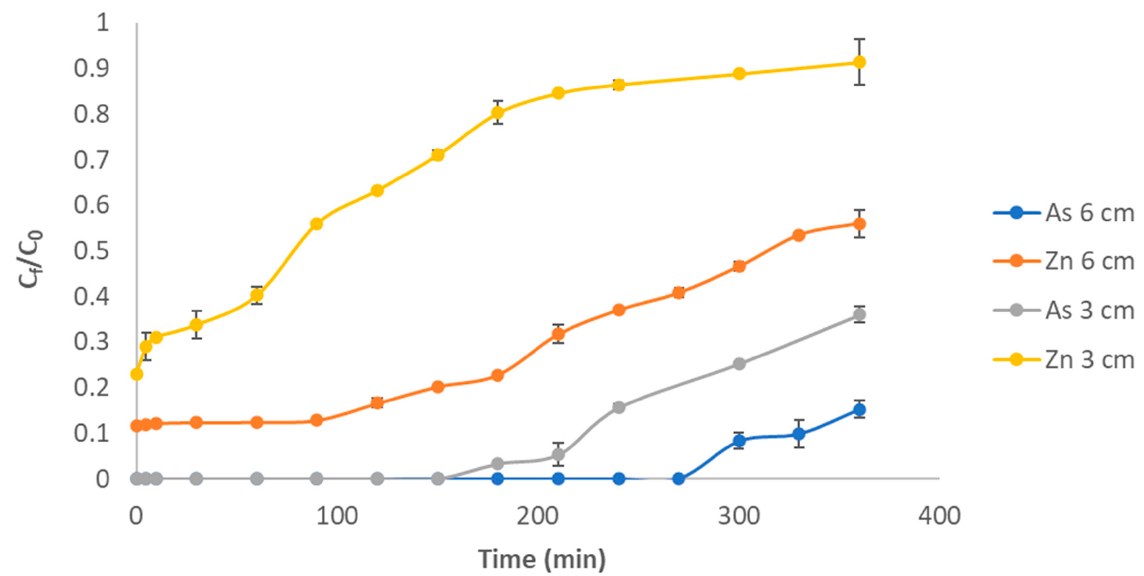
Figure 8. Arsenic and zinc sorption breakthrough curves of drop-fed columns with alginate beads containing biogenic iron compounds using different bed heights (1 mL/min flow rate).